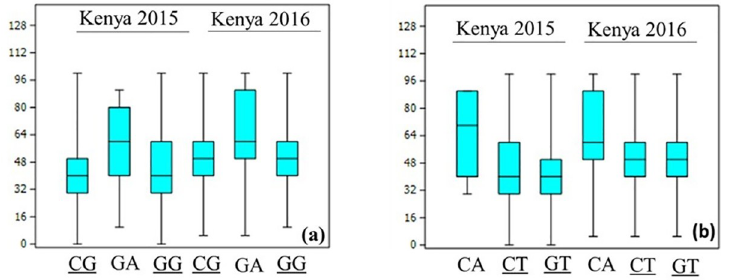
Fig 9. Effect of Sr2- linked haplotypes H3B.1 (a) and H3B.6 (b) on SR resistance in the two seasons at Kenya. Two favorable haplotypes identified at each locus are shown as underscored.